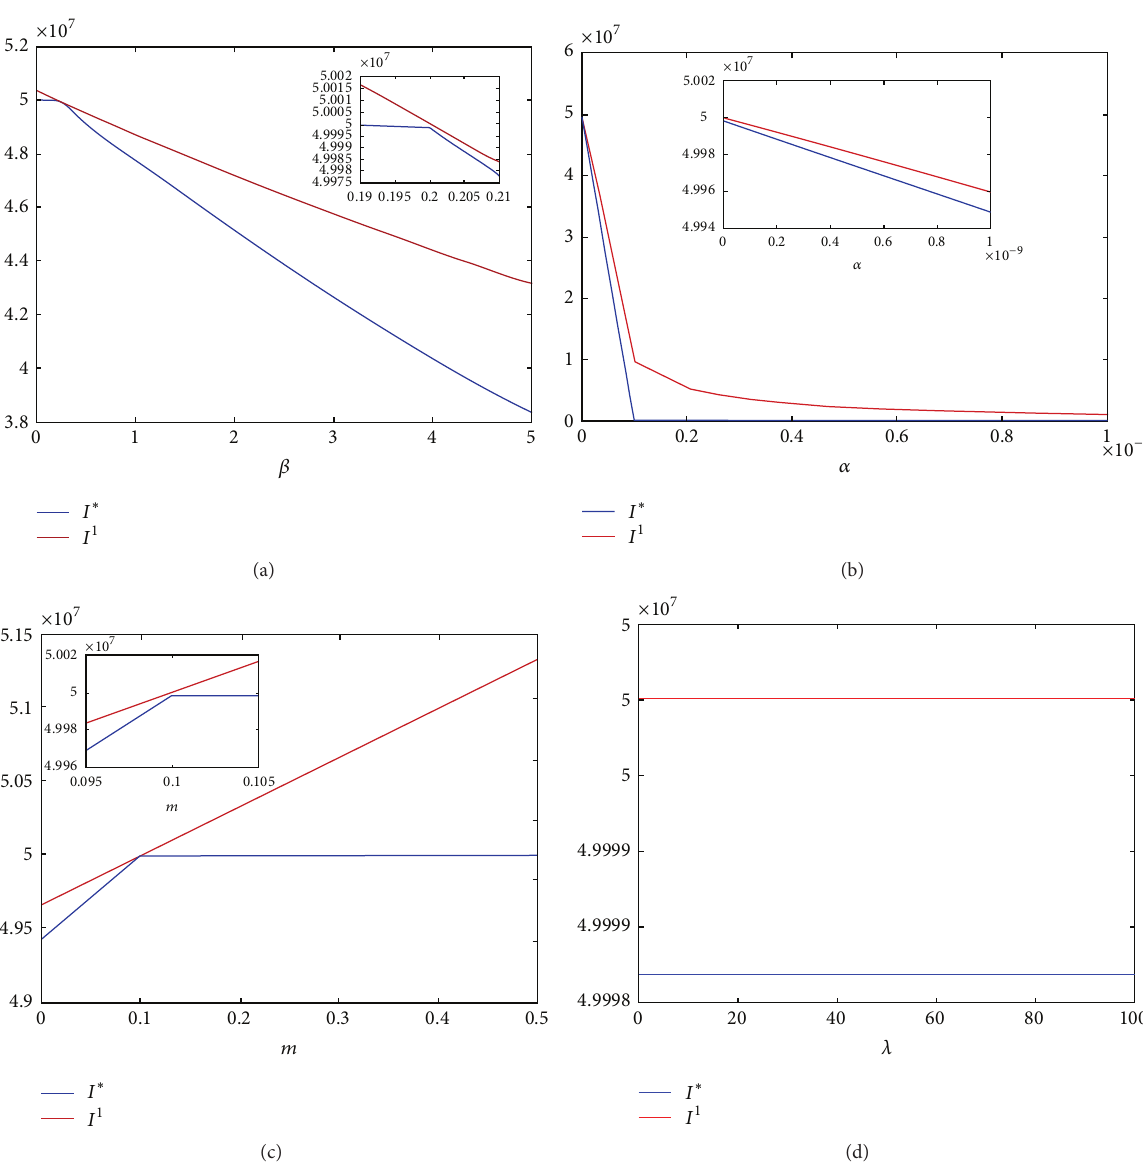
Figure 2: The comparison of 𝐼 ∗ with 𝐼 1 : (a) in terms of 𝛽 , where 𝛼 = 0 , (b) in terms of 𝛼 , where 𝛽 = 0.2 , (c) in terms of 𝑚 , where 𝛽 = 0.2 and 𝛼 = 0 , and (d) in terms of 𝜆 , where 𝛽 = 0.2 and 𝛼 = 0 . The other parameter values and the initial values can be seen in Table 1, unless we say